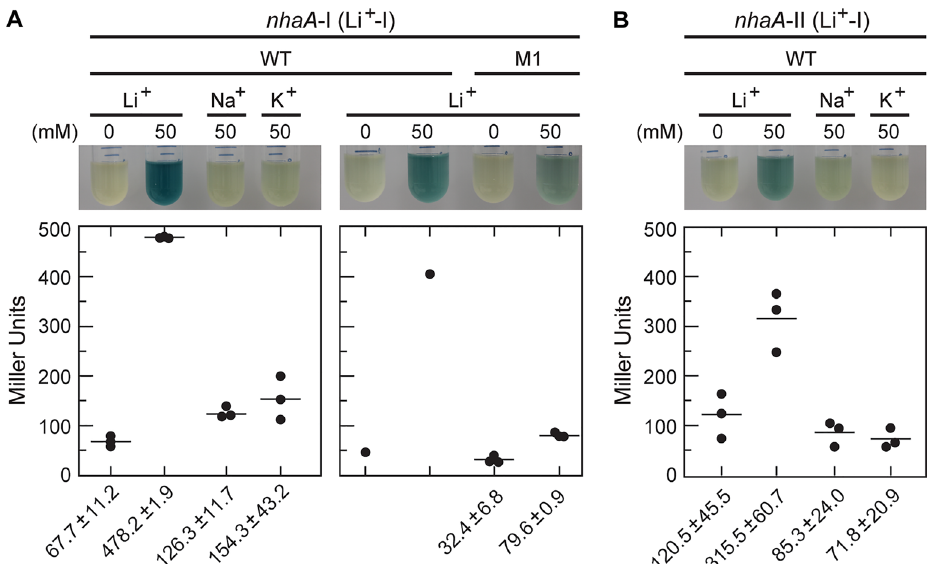
Figure 3. Quantitation of gene expression mediated by representative Li + -I and Li + -II riboswitches. ( A ) Left: E. coli cells carrying the WT nhaA -I (Li + -I) riboswitch-reporter fusion construct (see Fig. 2A ) grown in low salt LB medium at pH 9 either without or with supplementation with 50 mM LiCl, NaCl, or KCl as indicated. Either X-gal (top) or ONPG (bottom), respectively, was added after overnight incubation of cultures to visualize or quantify β-galactosidase reporter activity. Right: E. coli cells carrying the WT nhaA -I (Li + -I) or M1 nhaA -I (Li + -I) riboswitch-reporter fusion construct (see Fig. 2A ) cultured in low salt LB medium at pH 9 either without or with supplementation of 50 mM LiCl. The mean and standard deviation values are presented for experiments conducted in triplicate (n = 3). ( B ) E. coli cells carrying the WT nhaA -II (Li + -II) riboswitch-reporter fusion construct (Fig. 2C) were cultured in low salt LB medium at pH 9.0 without or with supplementation of 50 mM LiCl, NaCl, or KCl as